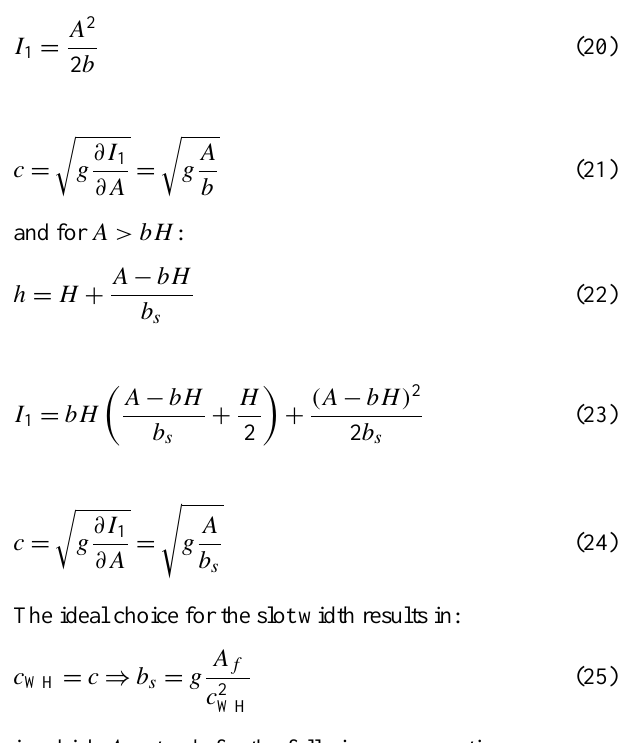
Figure 7. Upstream (a) and downstream (b) pressured head level.